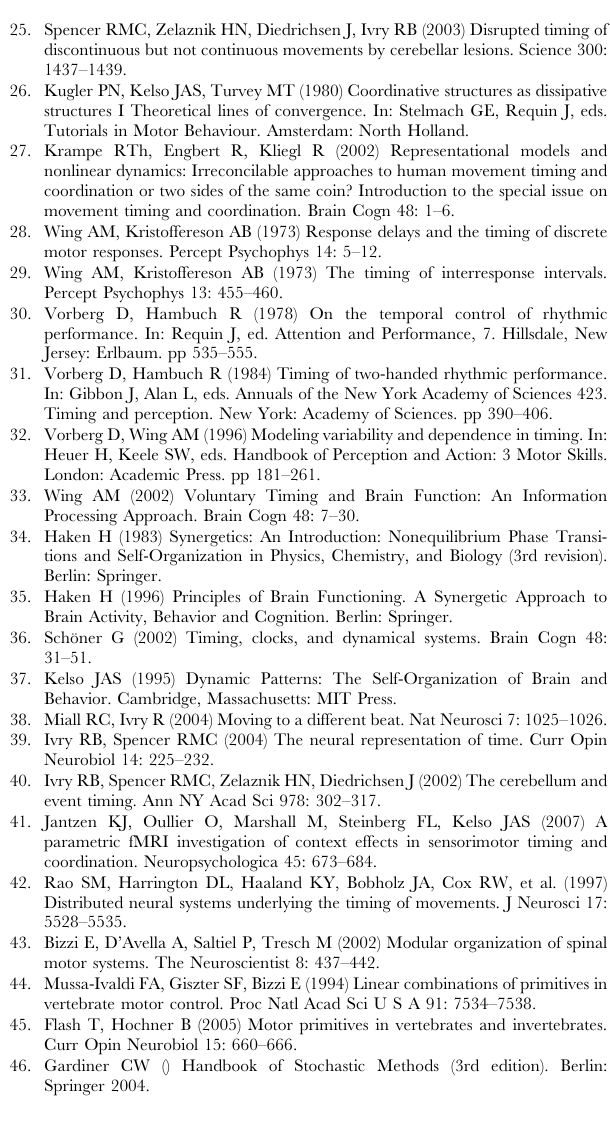
slowing down, the values of percent time to peak negative velocity are plotted in the reverse order of which they were